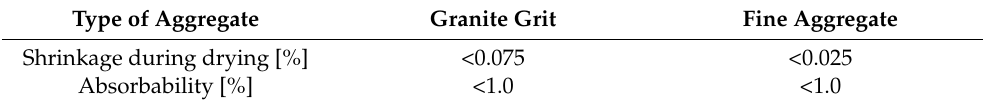
Table 4. Properties of the applied aggregate.